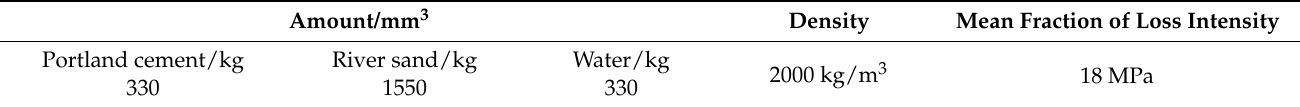
Table 2. Ratio and strength of similar materials.